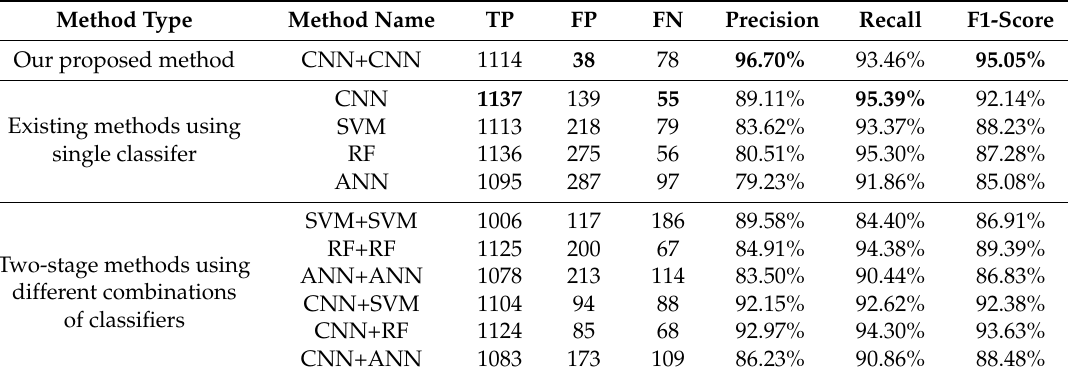
Table 6. The detection results of each method in Region 4.